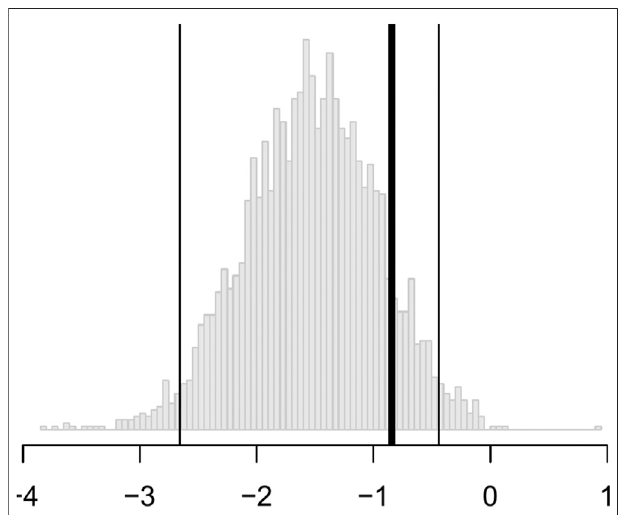
FIGURE 4 | Histograms of the bootstrap samples of ~ I Rand i.e. for the random d 0 business-as-usual allocation procedure. The thick black line is the best estimate of (cid:12) I 0 , the thin black lines are the con fi dence interval computed via the percentile method. More negative values are “ better ” as improvement is de fi ned as lowering the HSRD composite score corresponding to a patient being less